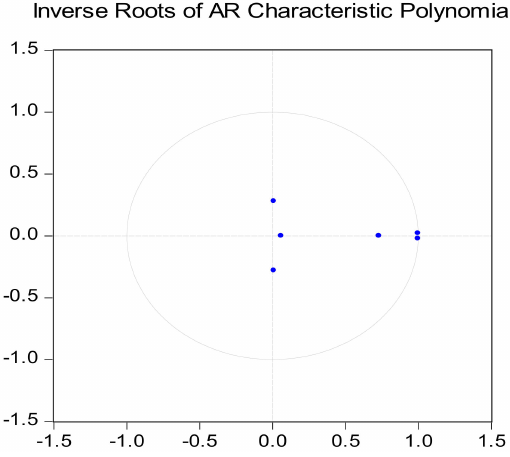
Figure 5. Unit root distribution